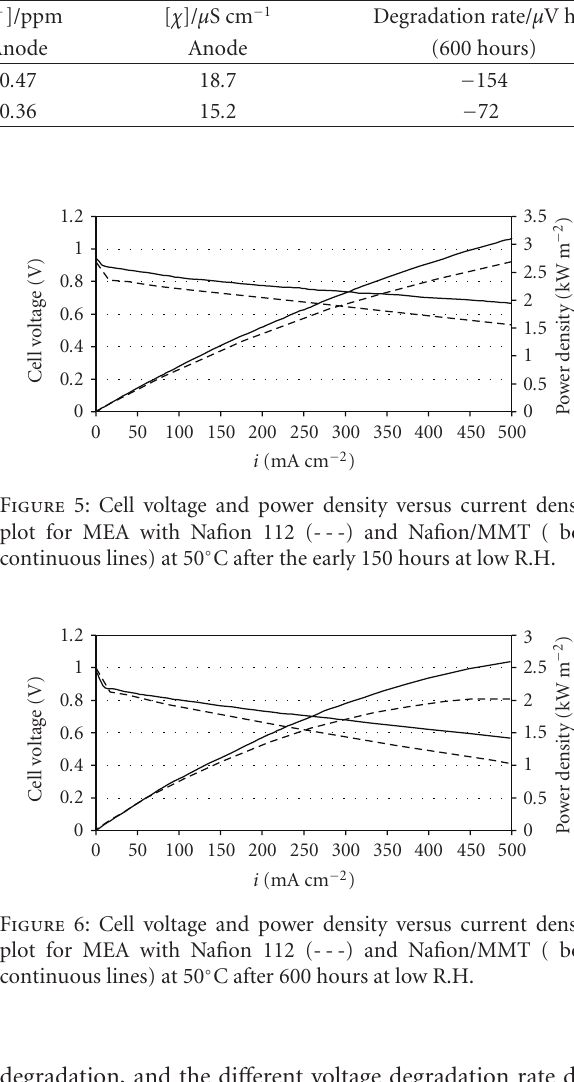
Table 1: Average fluoride concentration, conductivity, and final degradation rate during time tests.